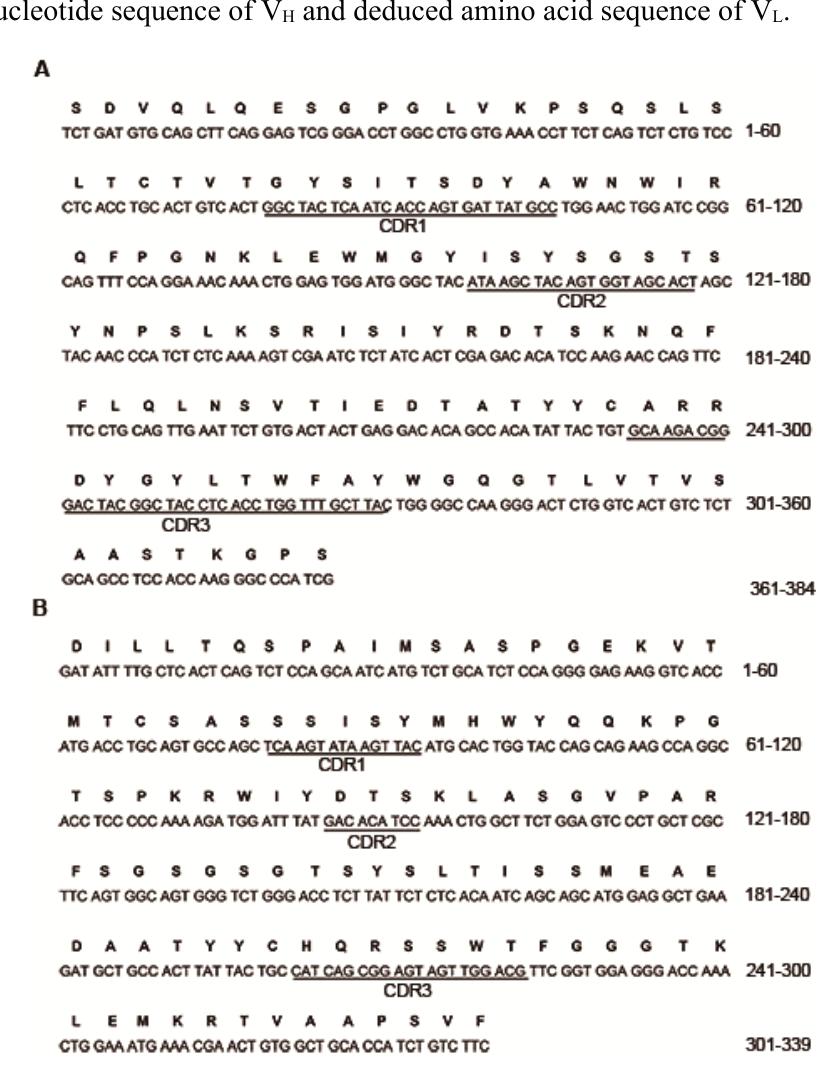
and V . The H L L